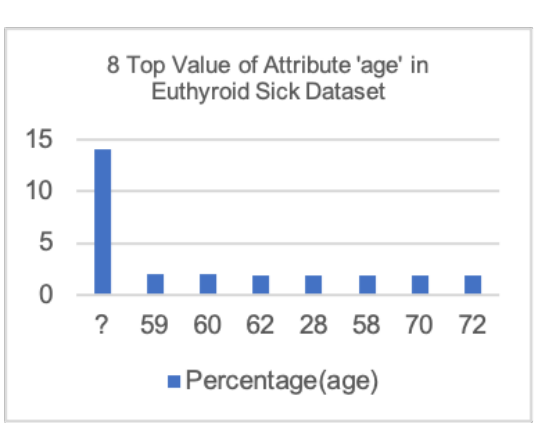
Figure 8. Age Attribute in Euthyroid Sick Dataset